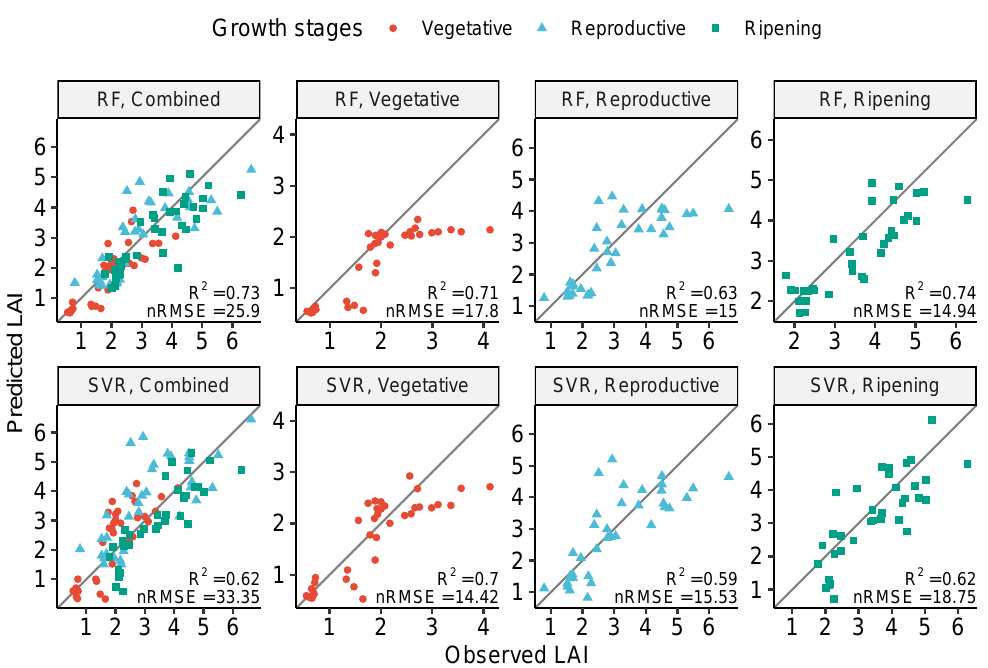
Figure 7. Observed vs. predicted LAI along the 1:1 line on standalone validation dataset of the random forests (RF) and support vector regression (SVR) models on first-derivative spectra. ‘Combined’ means the whole growing season model. ‘Vegetative‘, ‘Reproductive’ and ‘Ripening’ mean the single growth stage model of the specific growth